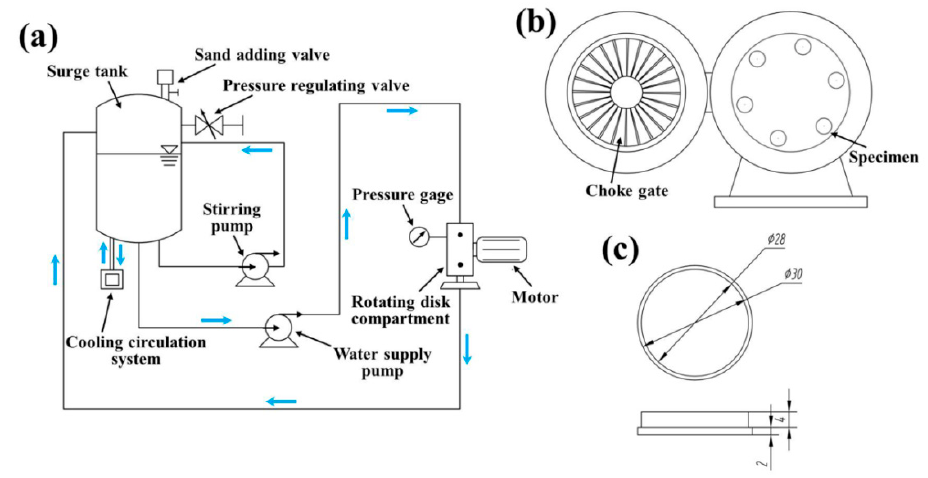
Figure 1. Schematic diagrams of the HAE test apparatus ( a ), the rotating disk compartment for the HAE test ( b ), and the corresponding specimen size ( c ). Table 1. Operating parameters of the HAE tests in 3.5 wt.% NaCl aqueous solution.